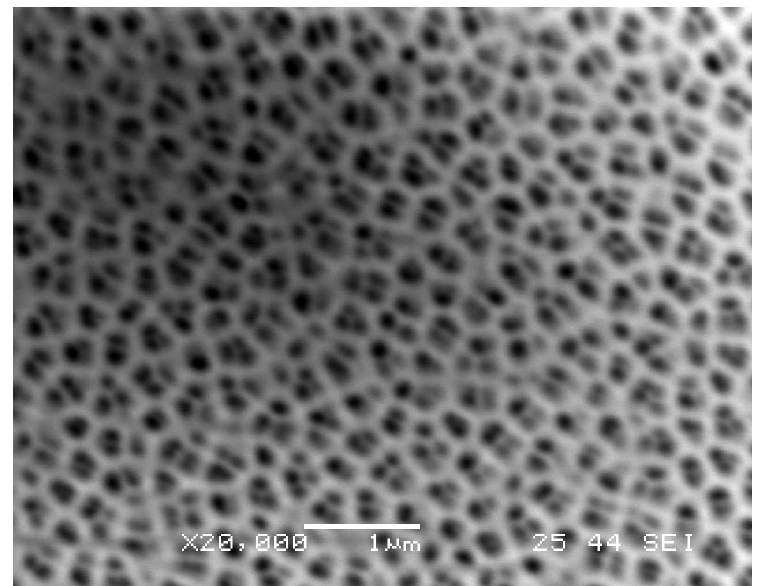
Figure 3. SEM image of porous alumina